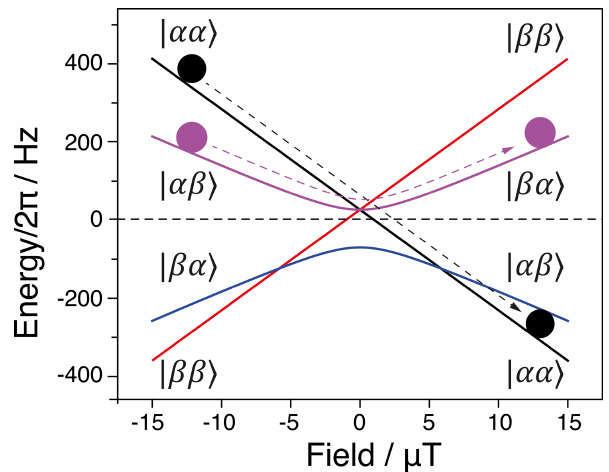
Figure 4. Correlation diagram for an adiabatic inversion. Simula- tion parameters: J IS = 100Hz; I and S spins are 1 H and 13 C nu- clei with the gyromagnetic ratios γ H = 2 . 68 × 10 8 rads − 1 T − 1 and γ C = 6 . 73 × 10 7 rads − 1 T − 1